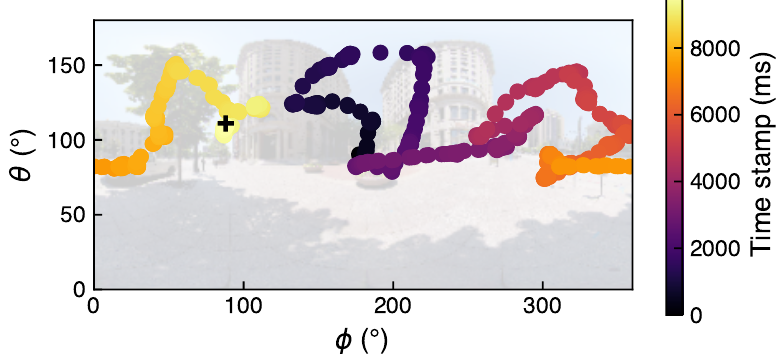
Figure 6. Example of raw gaze position in spherical coordinates for one subject in one trial. The back- ground image is the visual scene shown in this particular trial—for easier visualization of the gaze positions, the omnidirectional image is washed out in the figure. The black cross with coordinates ( 88°,111° ) indicates position of the search target in this trial. The color of the scatter points range from dark violet to light yellow and indicates the time stamp of each gaze position sample starting from the beginning of the trial: here, the participant started the search from the center of the image and ended around the target position. This trial lasted approximately ten seconds and the search target was successfully found by the participant.